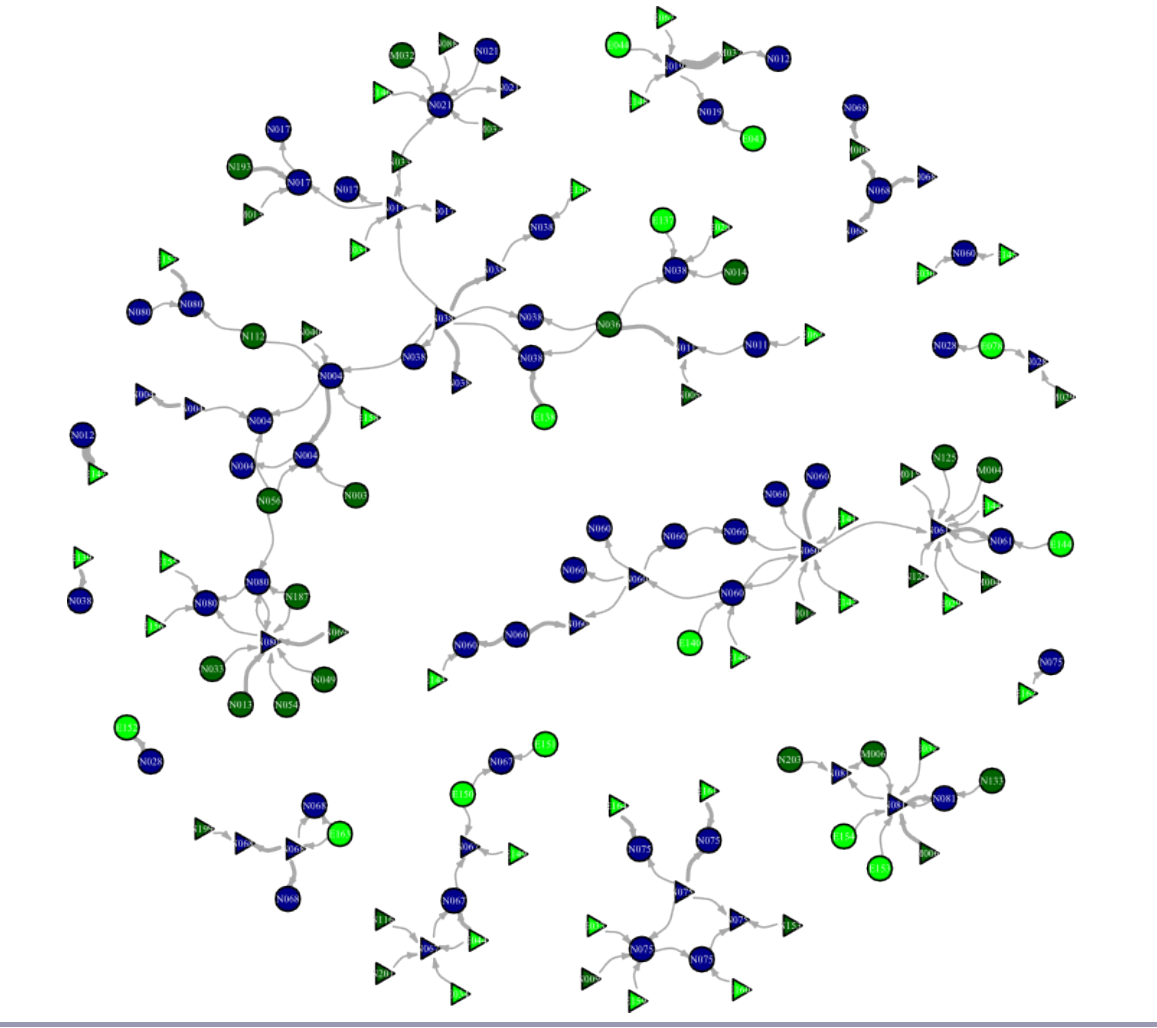
Fig. 1. Documented seed acquisition network. Blue, interviewed individuals; dark green, identified sources within the village; light green, identified sources outside the village. Cirlces, women; triangles,